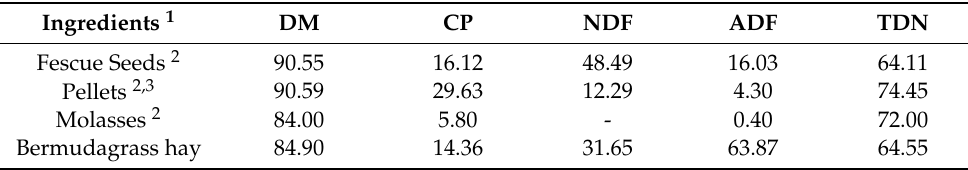
Table 2. Nutrient composition of the diet received by dams and